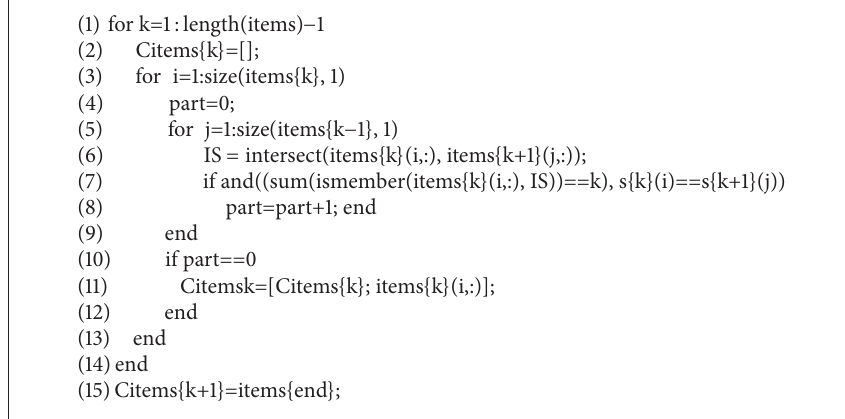
Algorithm 2: MATLAB code 3: the generation of closed frequent